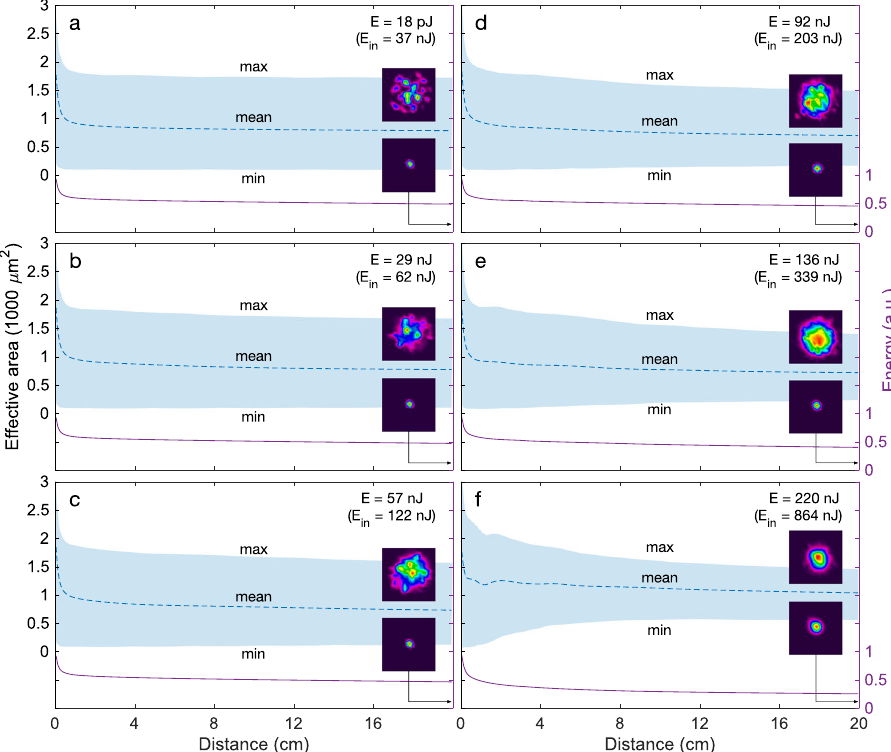
Fig. 5 Simulated effective area variations from the linear to nonlinear propagation regime with output (E) and input (E in ) pulse energy as indicated. The shaded region corresponds to the envelope of the effective area fl uctuations due to self-imaging with the maximum and minimum values denoted max and min respectively. The blue dashed line corresponds to the mean effective area calculated over one self-imaging period. Inset in a shows the effective area fl uctuations inside the envelope over four self-imaging periods. For each injected energy, examples of near- fi eld spatial intensity distributions corresponding to the minimum and maximum beam size are also illustrated at the fi ber output. The right axis (purple line) on each sub-panel shows the change in normalized energy as the result of leakage and infrared absorption along propagation with cumulative losses of 3.1, 3.3, 3.3, 3.4, 4.0, and 5.9 dB for a – f ,